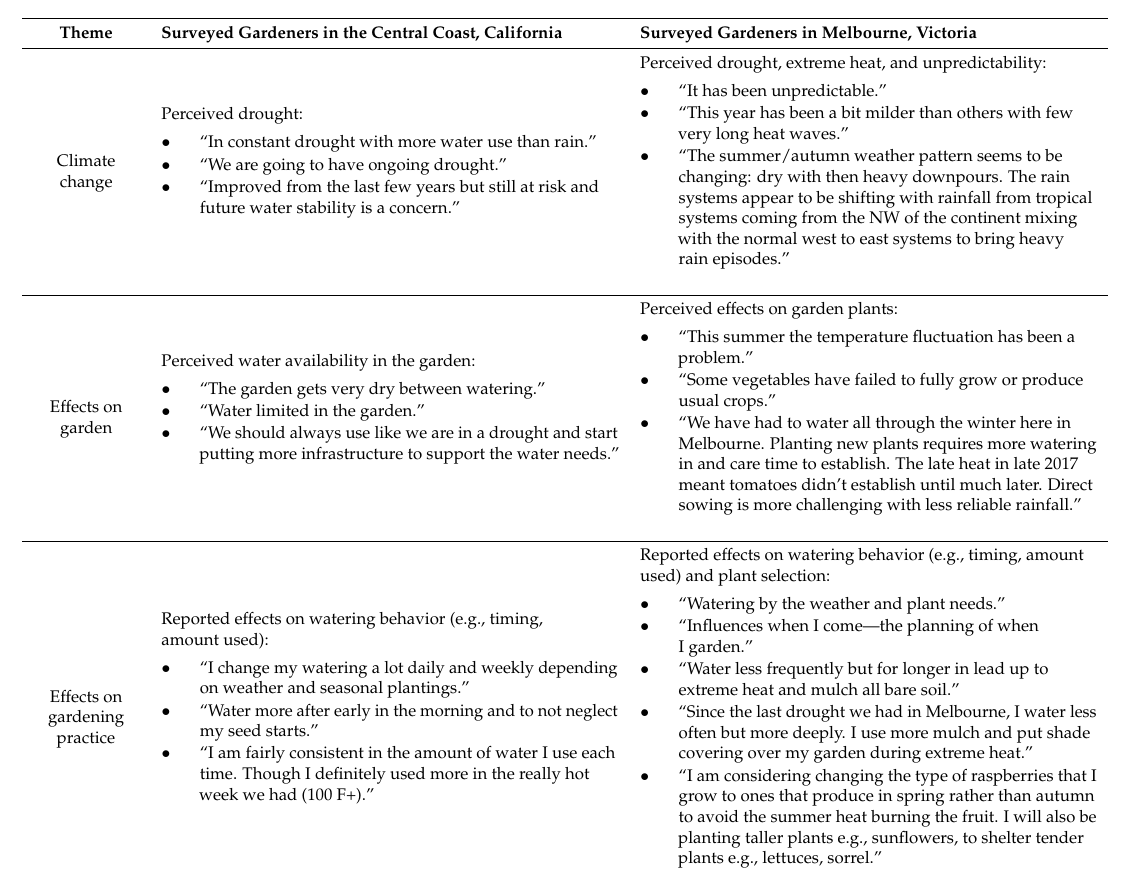
Table 4. Comparing gardener descriptions of perceptions of the weather patterns and climate change and its relation to the garden and garden management practices in the two study regions, coded according to a theme. Here, we show examples of the dominant responses of gardener perceptions. See Section 3.3. for